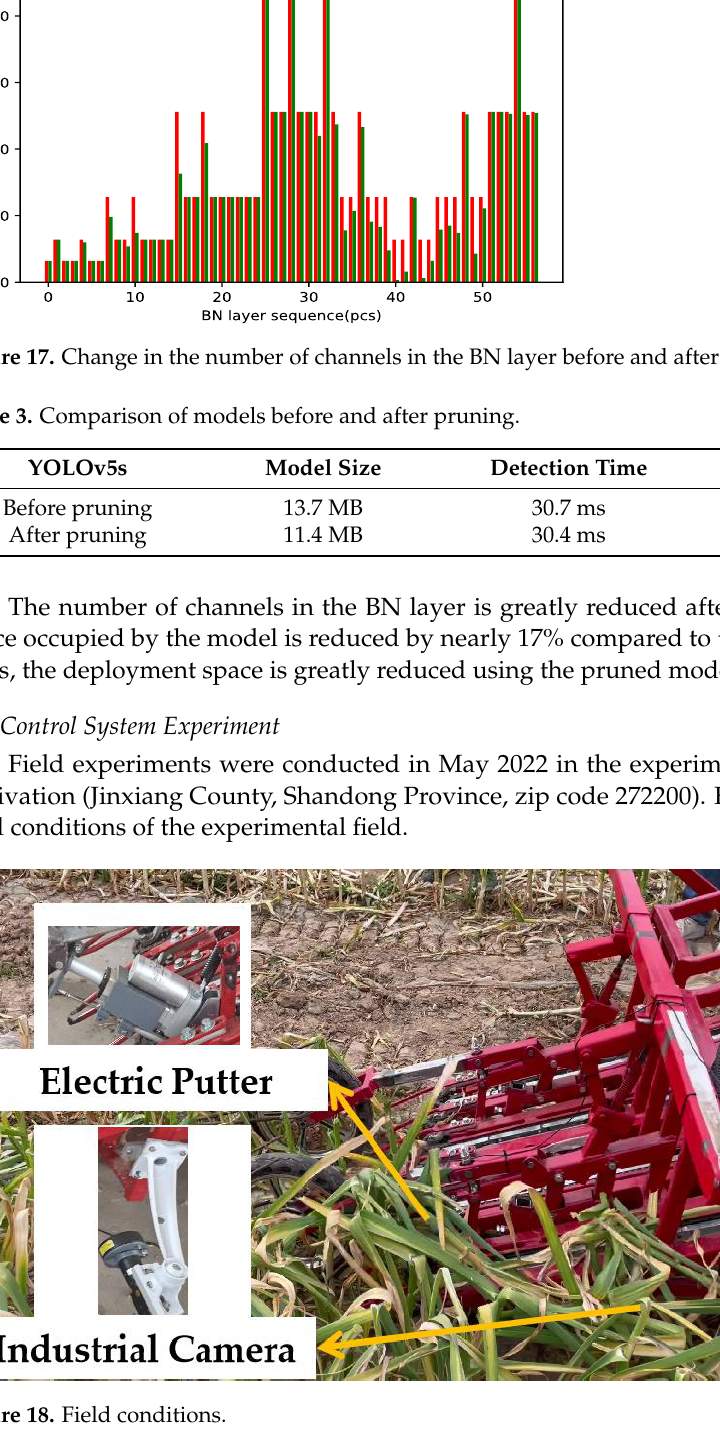
Figure 19. Upper computer monitoring interface. Set the initial garlic root length to 10 mm, start the digging depth automatic control system, and the change in each state quantity is shown in Figure 20.